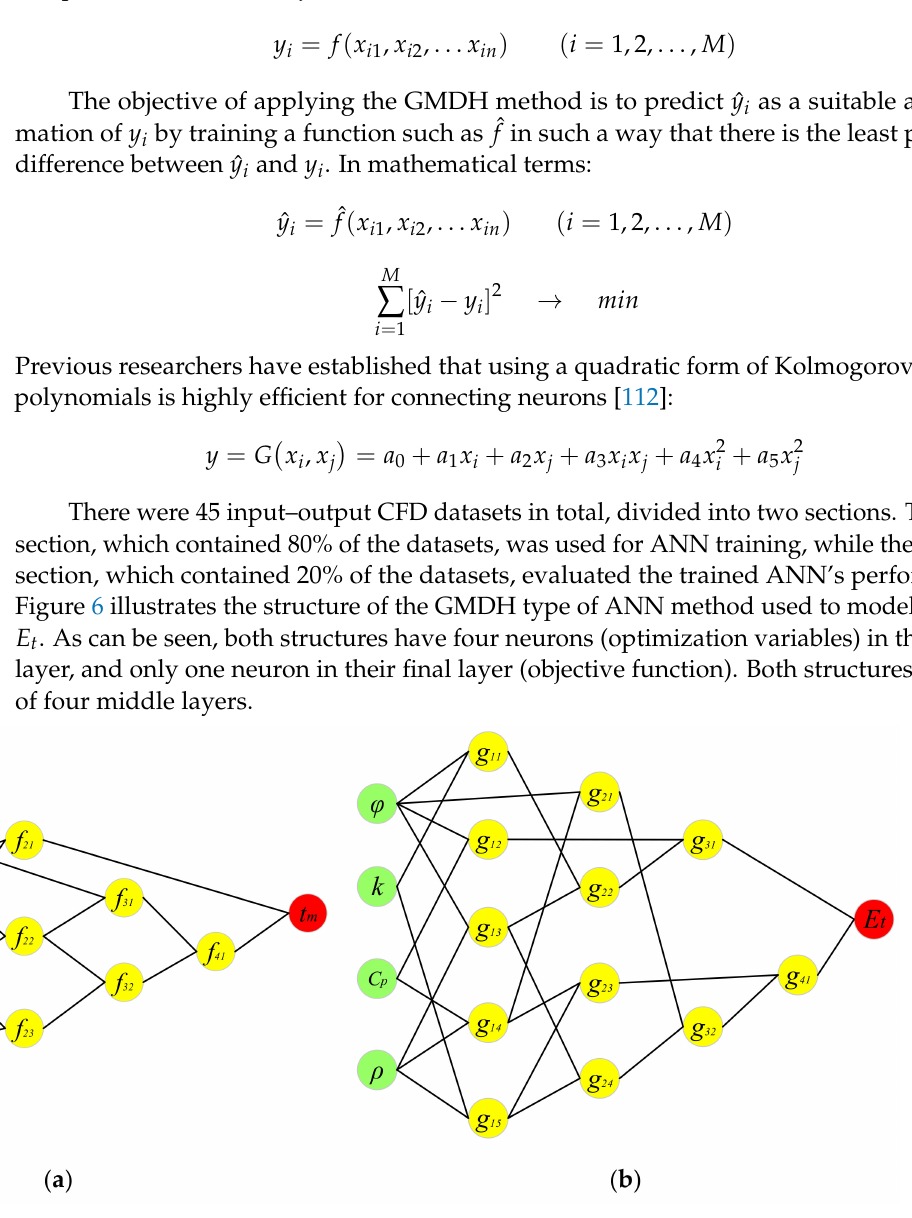
Figure 6. Evolved GMDH-type ANN structure for ( a ) t m and ( b ) E t